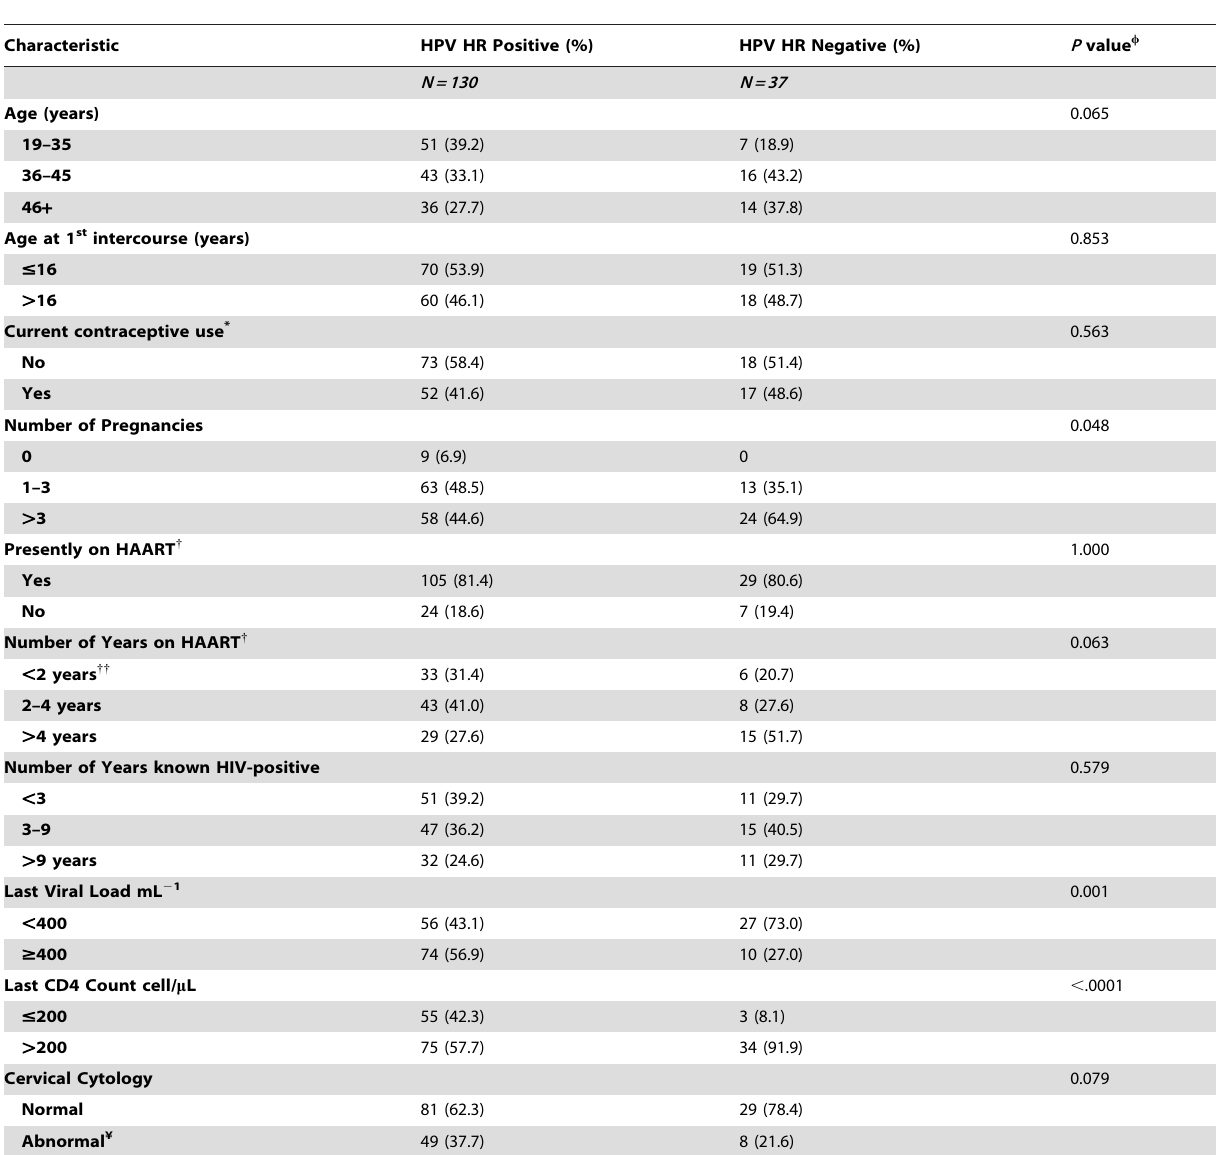
Table 1. Summary of demographic and behavioral characteristics of Bahamas HIV-positive women according to their HR HPV